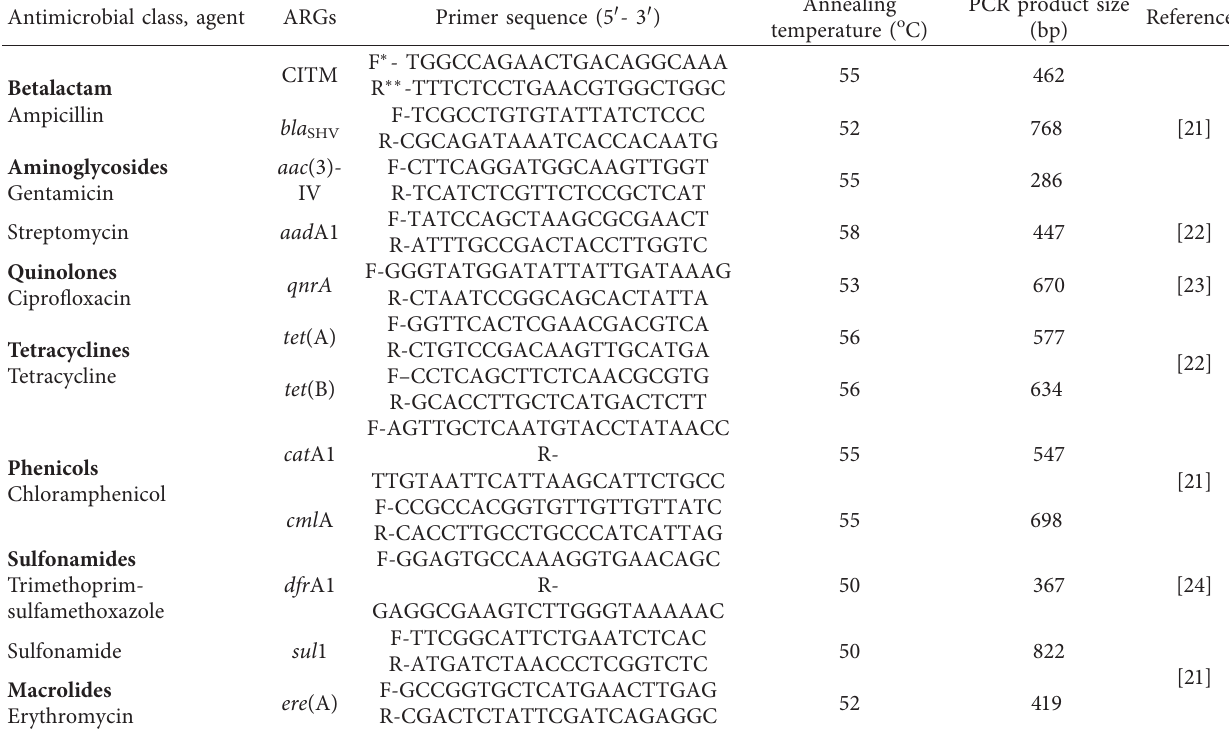
Table 1: Primers used to detect antimicrobial resistance genes (ARGs) in uropathogenic E. coli isolates. Antimicrobial class,